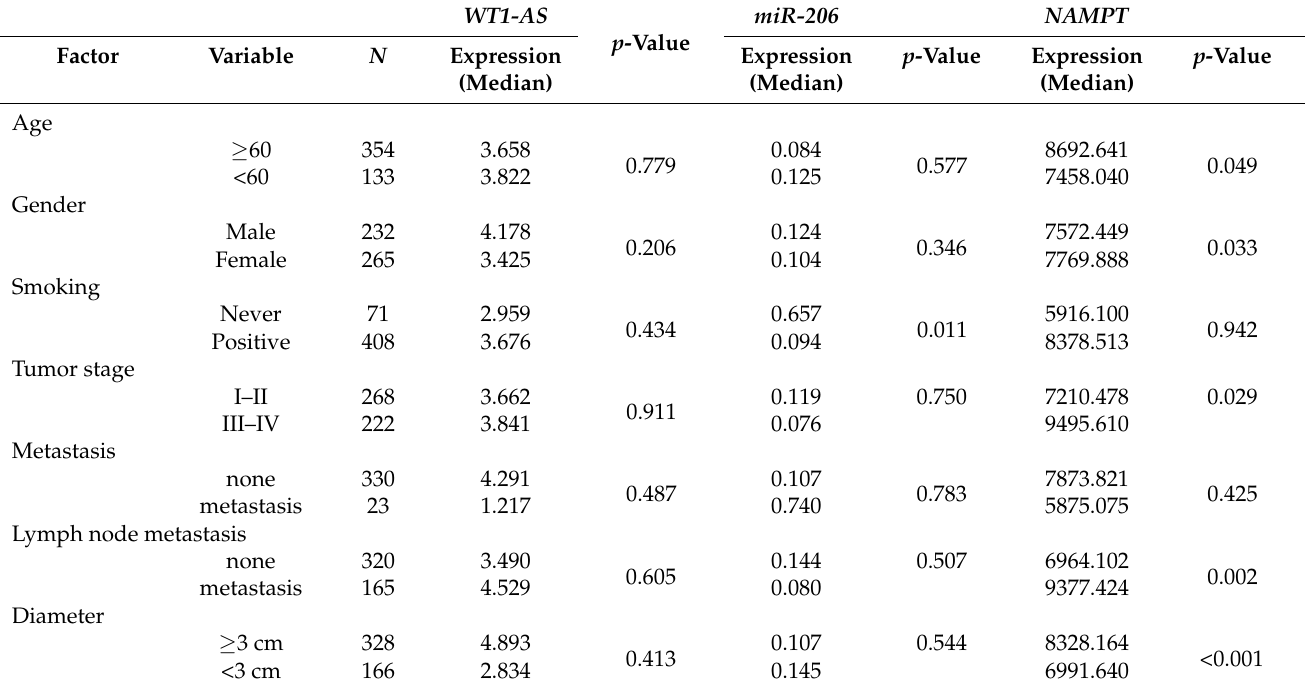
Table 2. Univariate analysis of the overall survival in LUAD patients based on clinical feature stratification and the relationship between WT1-AS, miR-206, and nicotinamide phosphoribosyltransferase (NAMPT)